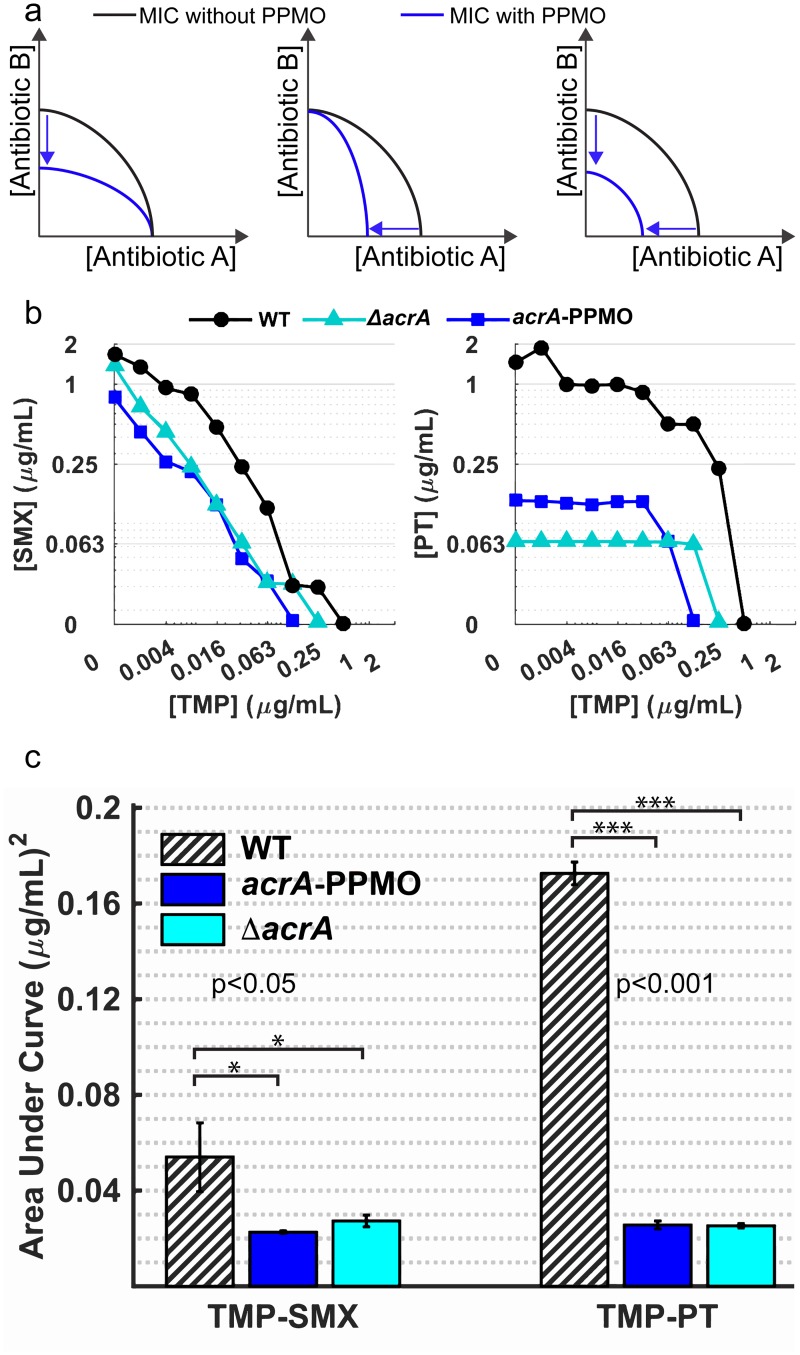
Targeting resistance genes with acrA-PPMO increases efficacy of antibiotic combinations and even makes the use of antagonistic antibiotic pairs possible.(A) Conceptual representation of the possible effects of efflux inhibition on the use of antibiotics pairs. Blue and black lines represent the MIC lines in two-dimensional gradients of drug pairs for bacteria with and without acrA-PPMO, respectively. The left panel represents an increase in susceptibility to antibiotic B, the middle panel represents an increase to antibiotic A, and the right panel represents an increase to both antibiotics. (B) MIC lines determined in two-dimensional gradients of (left) trimethoprim-sulfamethoxazole and (right) trimethoprim-piperacillin/tazobactam for wild type E. coli (black line), with 10 μM acrA-PPMO (blue line), or the acrA deletion mutant (cyan line). (C) Bar graphs demonstrating the efficacy of antibiotic combinations shown in (B). Area under the MIC curves in (B) are significantly reduced relative to the wild type E. coli (bars with black diagonal lines) for both antibiotic combinations when 10 μM acrA-PPMO (blue bars) is used or acrA (cyan bars) is physically deleted. All measurements were done in triplicate, and p-values for significance were calculated with Student’s t-test.